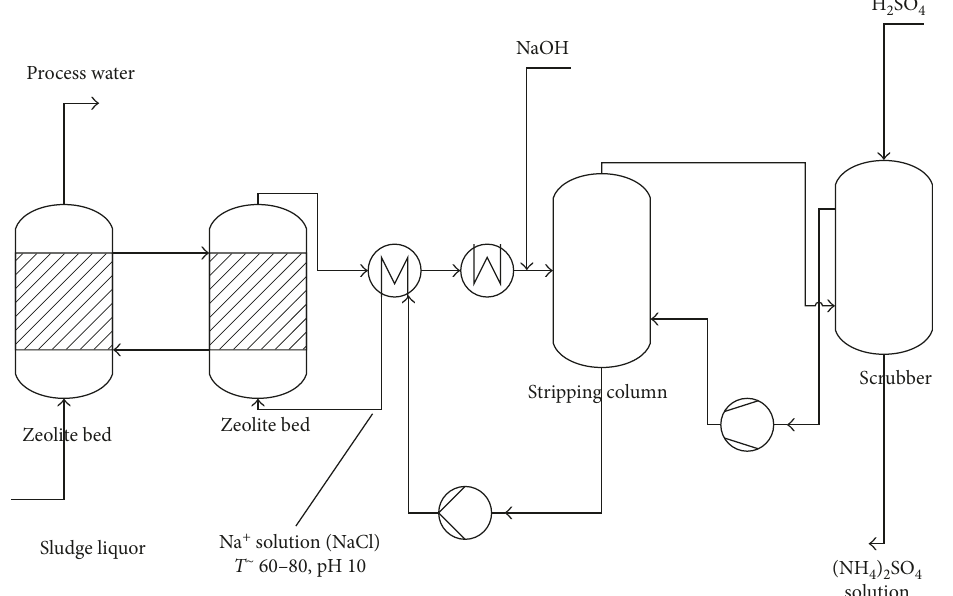
Figure 8: Ion exchange loop stripping configurations